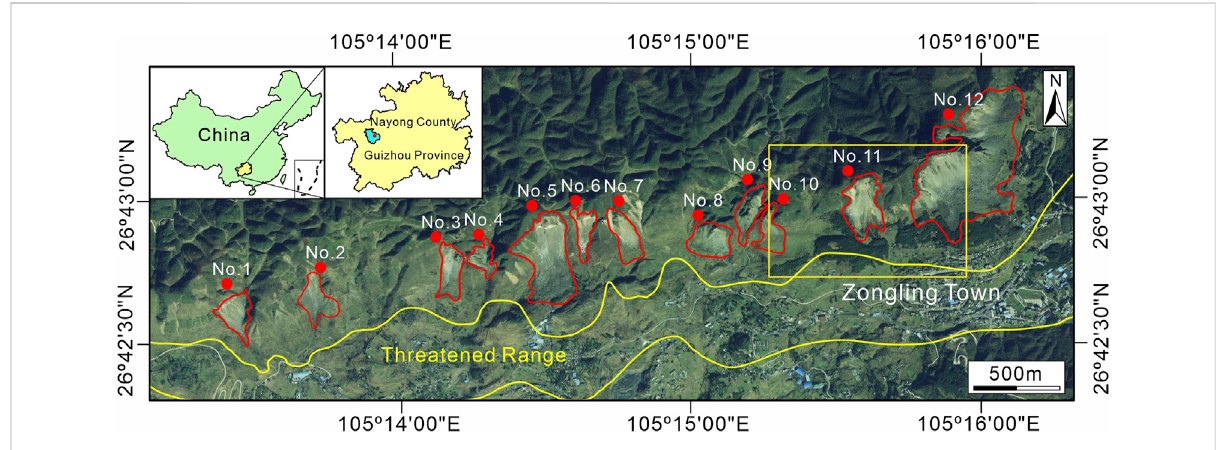
FIGURE 1 Distribution of 12 rockfall-dominated talus slopes in the Zongling rockfall zone (image source: Google Earth).